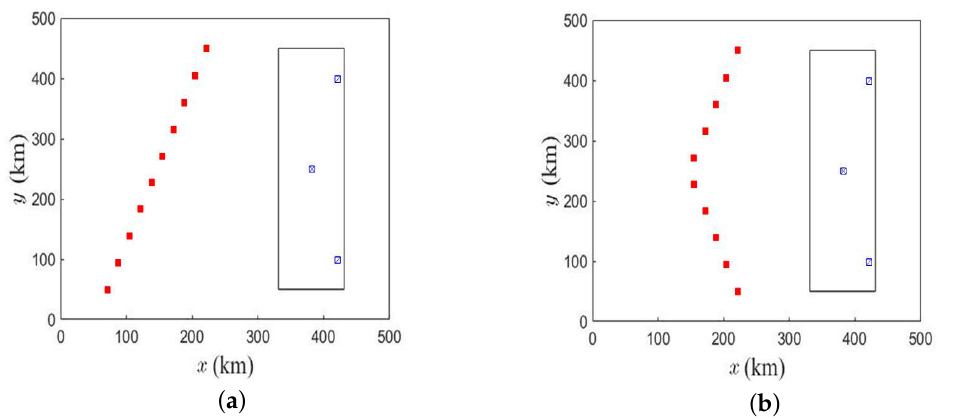
Figure 1. Attack stations in ( a ) slant formation; ( b ) pincer